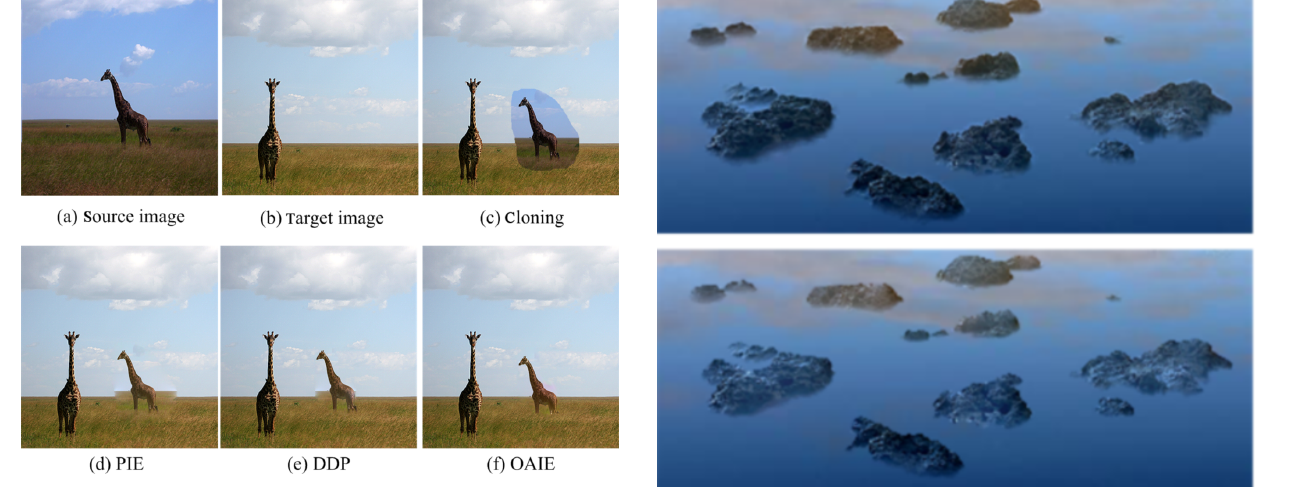
P. Image melding: Combining